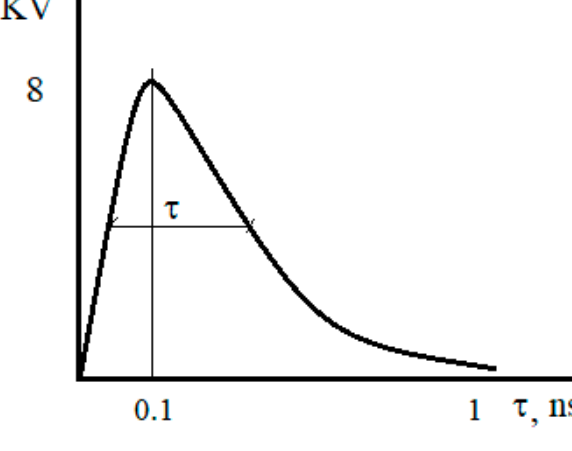
Figure 4. Shape of an electromagnetic pulse [9].